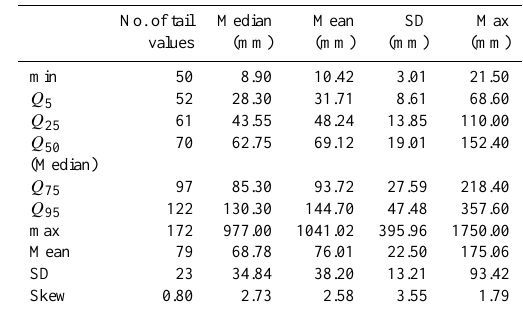
Table 2. Some basic statistics of the 15137 tail samples defined for an N -year record as the N largest nonzero